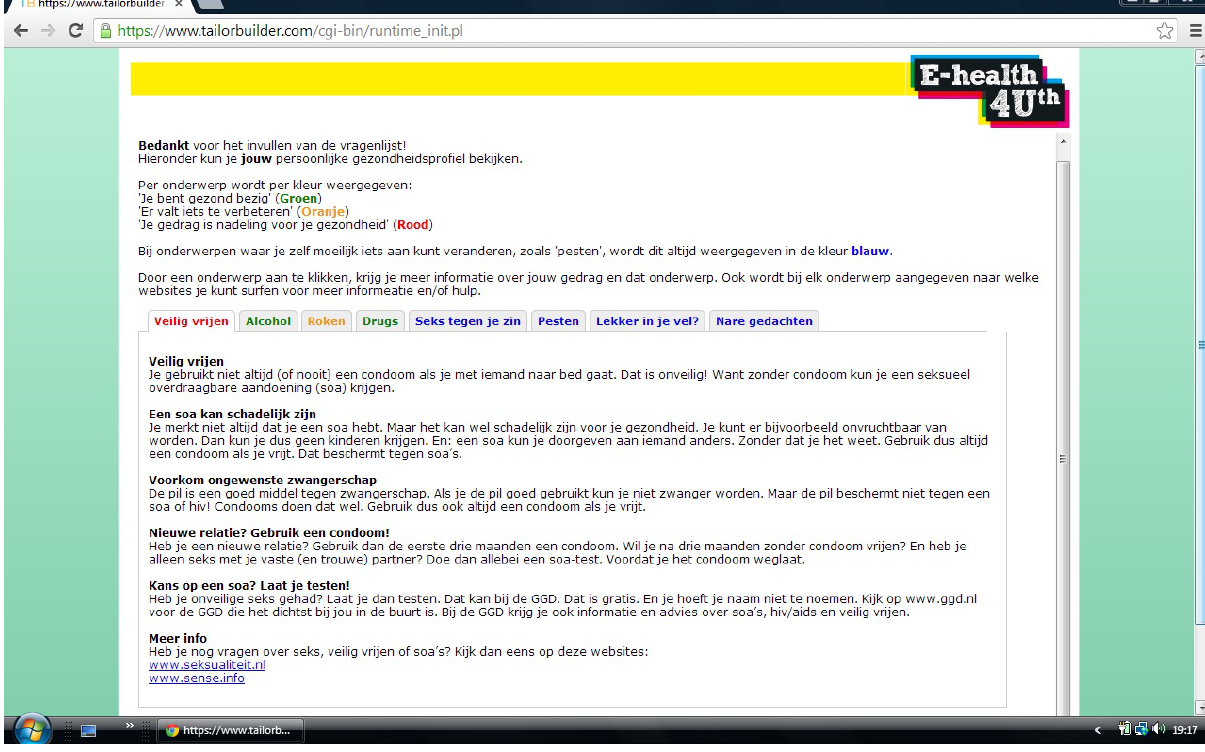
Figure 2. Screenshot of the Web-based tailored messages. This message was presented to adolescents who answered that they have had unsafe sex (left-most tab). The message is displayed in red, indicating unhealthy behavior. The messages on the other topics are presented when clicking on the other (colored)